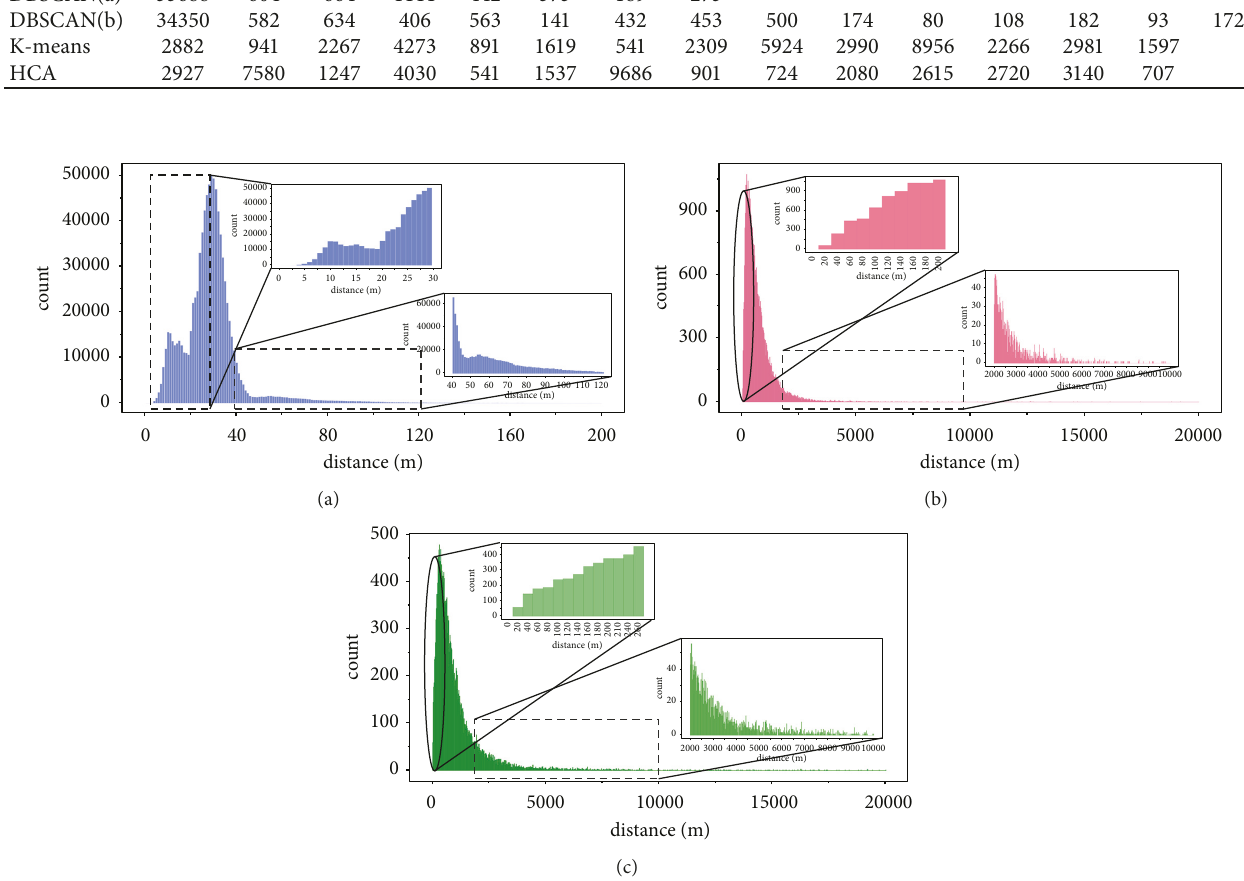
Figure 9: Trajectory point distance distribution of: (a) original data; (b) DP-compressed data; (c) SW-compressed data.